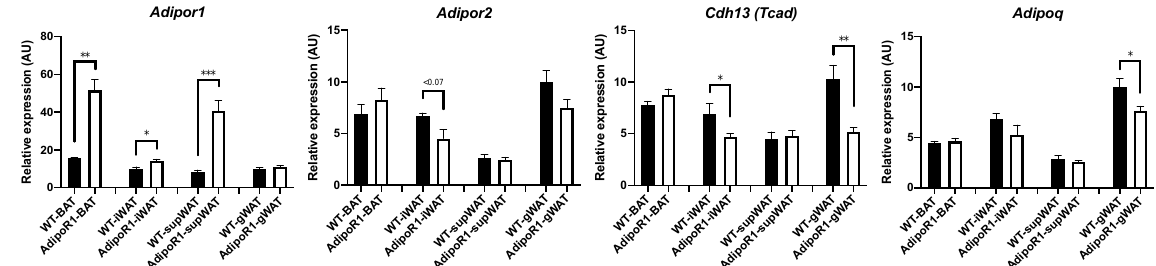
Figure 6. Increased expression of adiponectin receptor 1 and decreased expression of T-cadherin in classical brown or beige adipose depots of AdipoR1 mice after cold exposure. Indicated adipose depots of WT and AdipoR1 female mice after cold acclimation were determined for expression of adiponectin ( Adipoq ) and adiponectin receptors, including adiponectin receptor 1 ( Adipor1 ), adiponectin receptor 2 ( Adipor2 ), and T-cadherin ( Cdh13/Tcad ). Timeline and procedures were described in Figure 1. Classical iBAT, iWAT, supWAT (both of potential white adipose depots for browning or beiging), and gWAT in WT and AdipoR1 female mice were harvested, extracted, and measured to evaluate expression of adiponectin and its receptors ( n = 3–8 for each group). Data were presented as relative means (normalized to β-actin in arbitrary units, AU) ± SEM. * p ≤ 0.05; ** p ≤ 0.01; *** p ≤ 0.001.